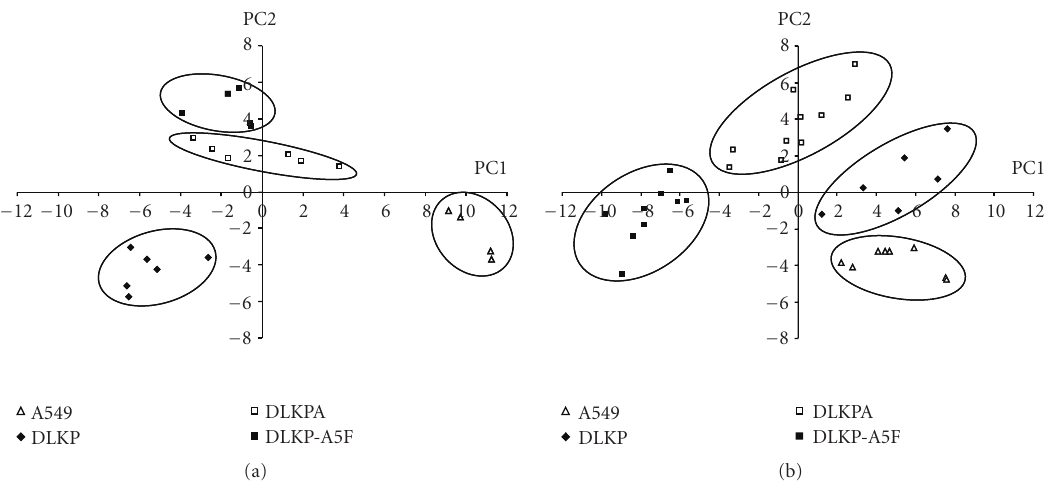
Figure 3: PCA scores plots for A549, DLKP, DLKPA, and DLKP-A5F, whole-cell data. Analysis is shown for G1 13 21 (a), G2 17 33 (b). The right hand panel is reproduced from [24] with permission.